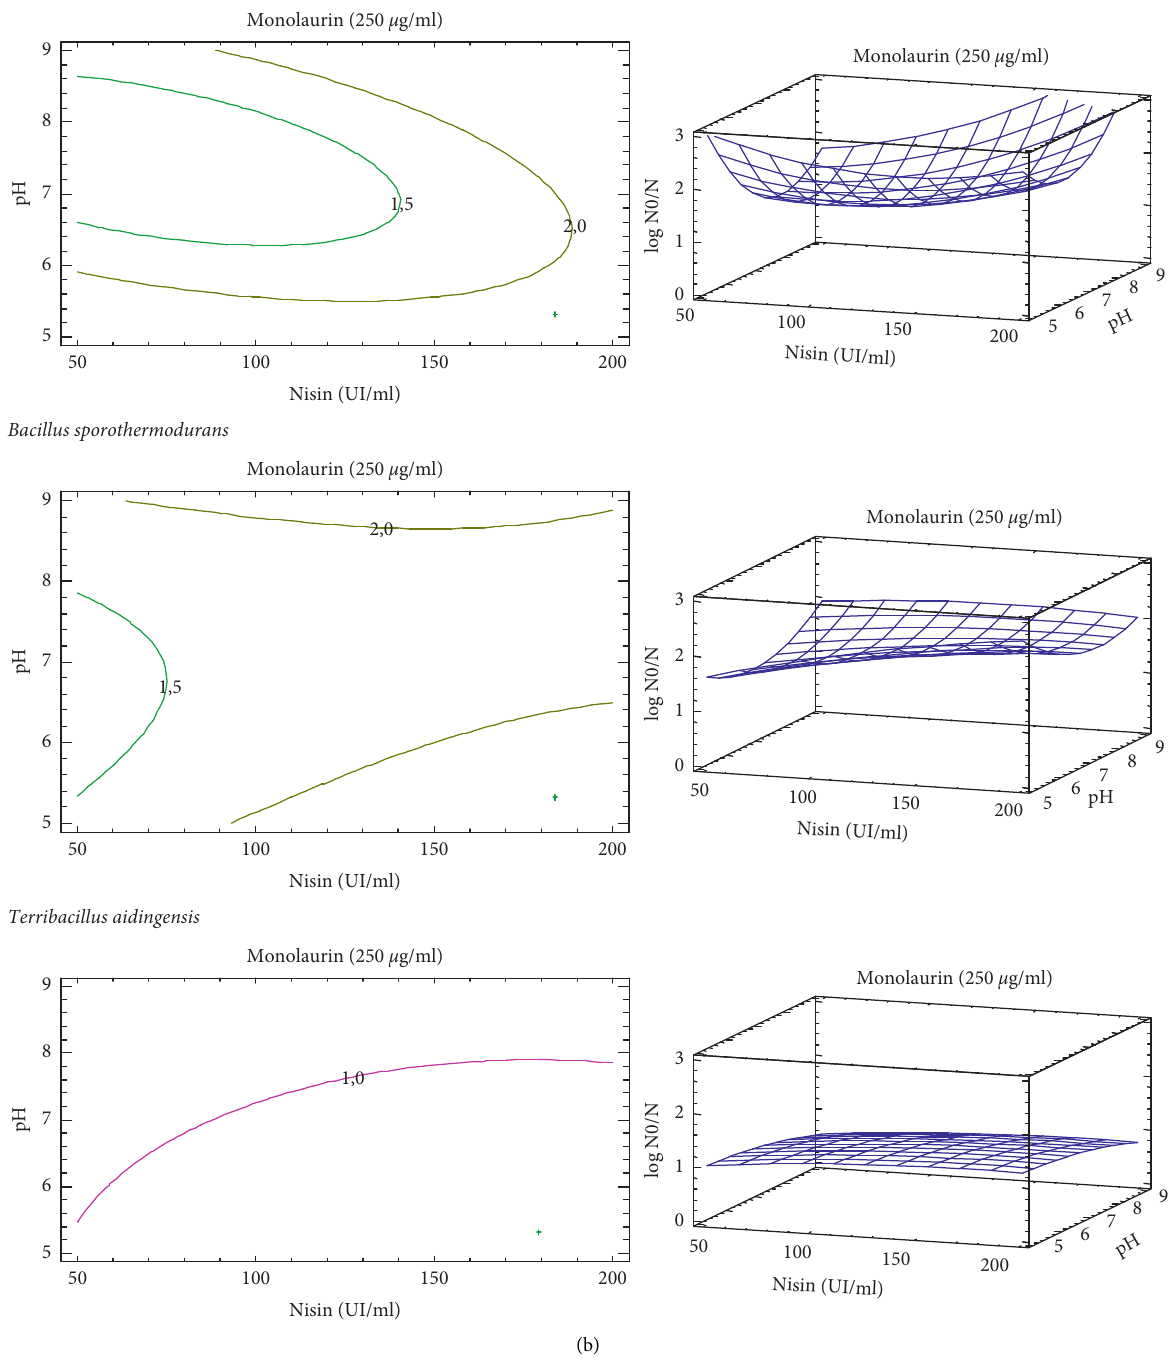
Figure 2: Response surface and contour plots showing the effects of nisin and pH on the spores’ inactivation in (a) distilled water and (b) milk. ∗ The data on the contour maps are log N 0 /N. N 0 represents the plate count of the untreated spore suspension (10 7 spores/ml), and N represents the plate count after treatment with antimicrobial